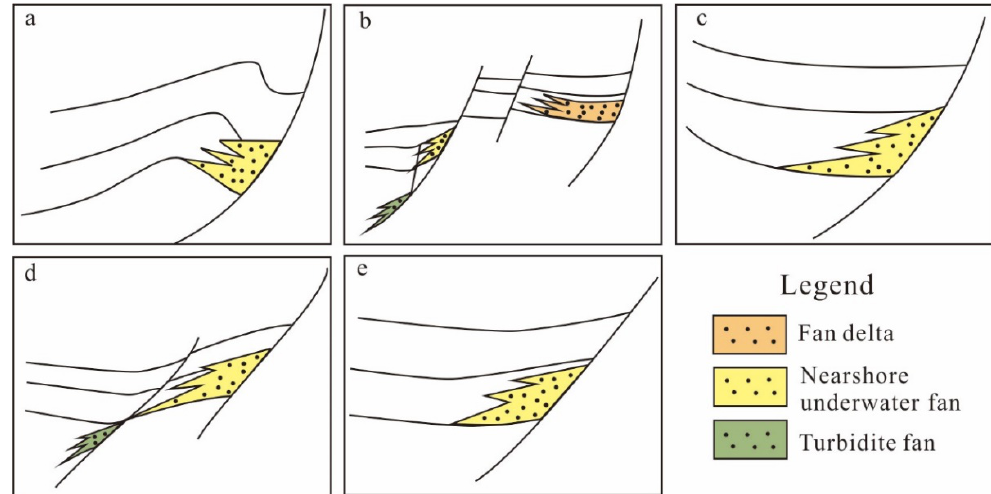
Figure 7. The types of boundary faults and the distribution pattern of glutenite rock in the steep slope belt in Guojuzi area. (( a ). Convex-listric combination; ( b ). convex-ramp-flat combination; ( c ). concave-listric combination; ( d ). concave-step combination; e. concave-planar combination).